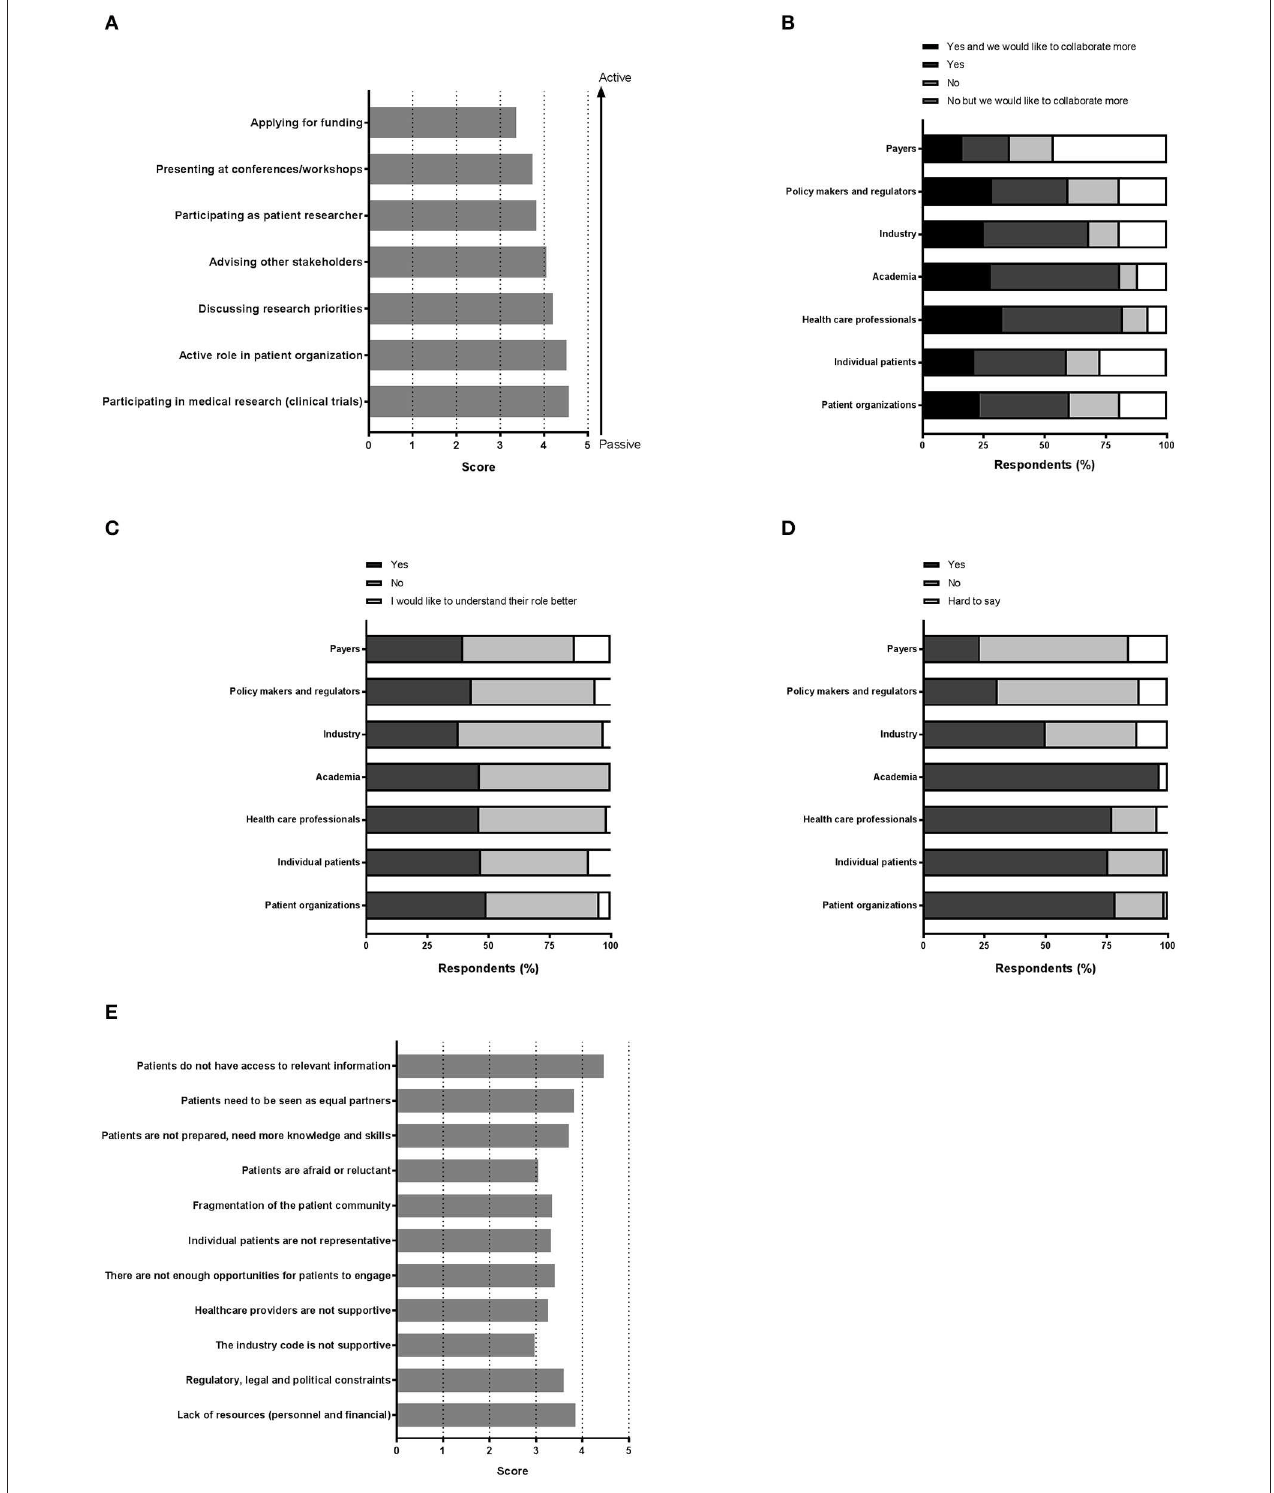
FIGURE 2 | “Perception on the various aspects of patient involvement.” Respondents were asked to reply to statements with a degree of agreement on aspects including (A) the importance of the patient in medical research, (B) collaboration, (C) the role of each stakeholder, (D) trust, and finally (E) barriers.